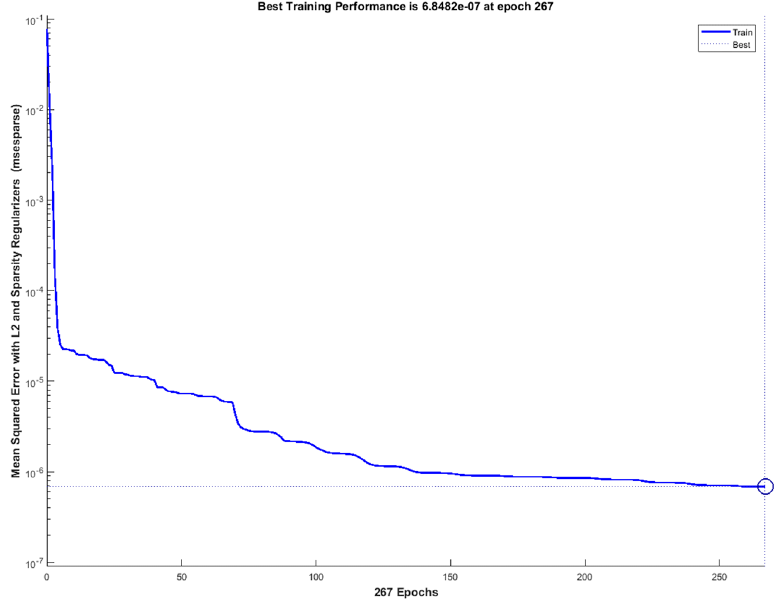
Figure 5. Mean squared error dynamic of autoencoder.